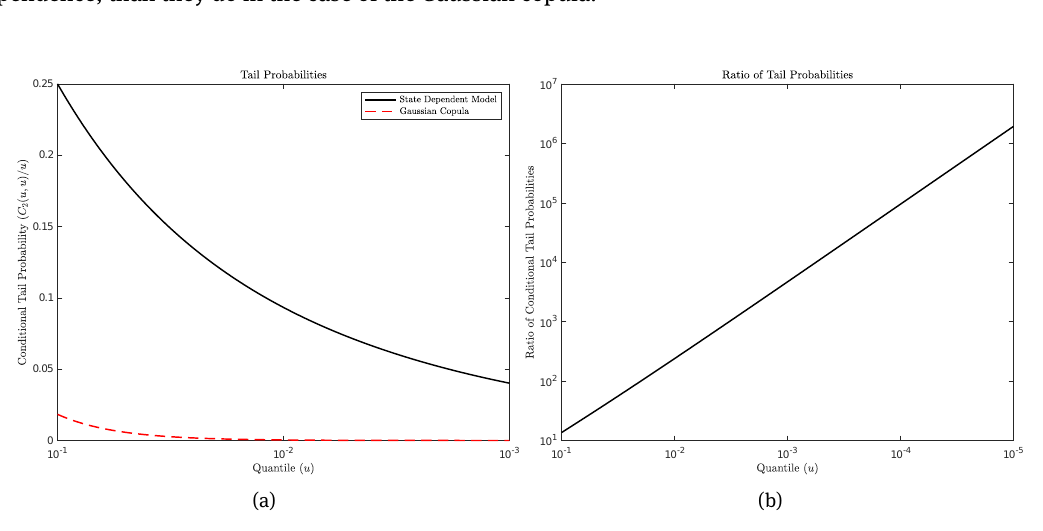
Figure 6.1: Panel (a) illustrates conditional tail probabilities of the form C ( u , u )/ u , where C is a copula function. Recall that if ( X , Y ) has copula C , then C ( u , u )/ u = P ( X ≤ x u | Y ≤ y u ) , where x u and y u are the 100 u th percentiles of X and Y , respectively. Solid line corresponds to the proposed model, in which case copula is given by (6.1) with n = 2 . Parameters are ( a 1 , a 2 ) = (0.25, 0.04) , ( p 1 , p 2 ) = (0.25, 0.75) and β = 0.90 . Dashed curve corresponds to two-dimensional Gaussian copula with correlation 0.23 ≈ ( a 1 p 1 + a 2 p 2 ) 2 . Panel (b) depicts the ratio of the conditional tail probabilities (i.e. the ratio of the solid curve to the dashed curve, from Panel (a)) on the log-log